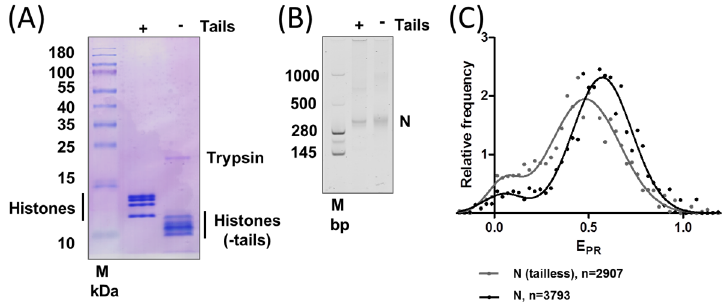
Figure 2. Removal of histone tails changes the structure of nucleosomes. ( A ) Removal of histone tails by trypsin changes their mobilities in the denaturing gel; ( B ) Intact and tailless nucleosomes have similar mobilities in a native gel; ( C ) Typical frequency distributions of proximity ratios (E PR ) for intact (N) and tailless nucleosomes (N(tailless)). Analysis by single-particle Förster resonance energy transfer (spFRET) microscopy. n is the number of analyzed nucleosomes.